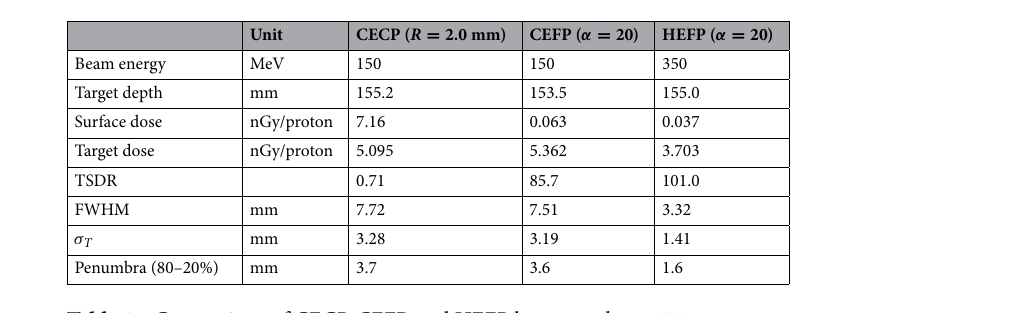
Table 1. Comparison of CECP, CEFP, and HEFP beams at d T